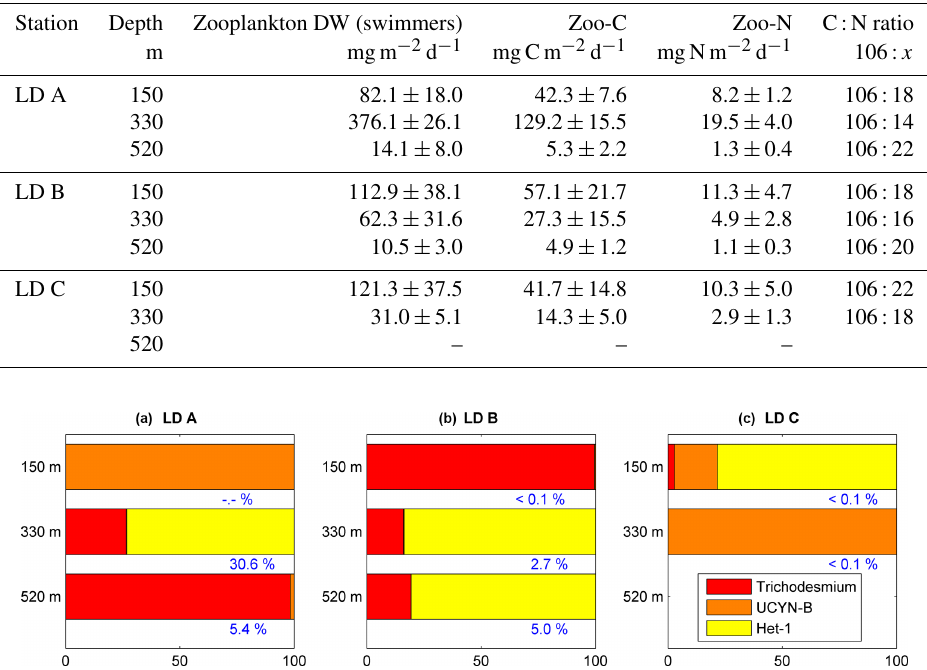
Figure 5. Relative contribution of each diazotroph ( Trichodesmium in red, UCYN-B in orange and het-1 in yellow) to the total PC associated with diazotrophs (diazotroph-PC) in the sediment traps at 150m (top), 330m (middle) and 520m (bottom), at the three stations LD A (a) , LD B (b) and LD C (c) . Values in blue correspond to the contribution of diazotroph-PC to total PC measured in the traps. No Trichodesmium valid data available at LD A